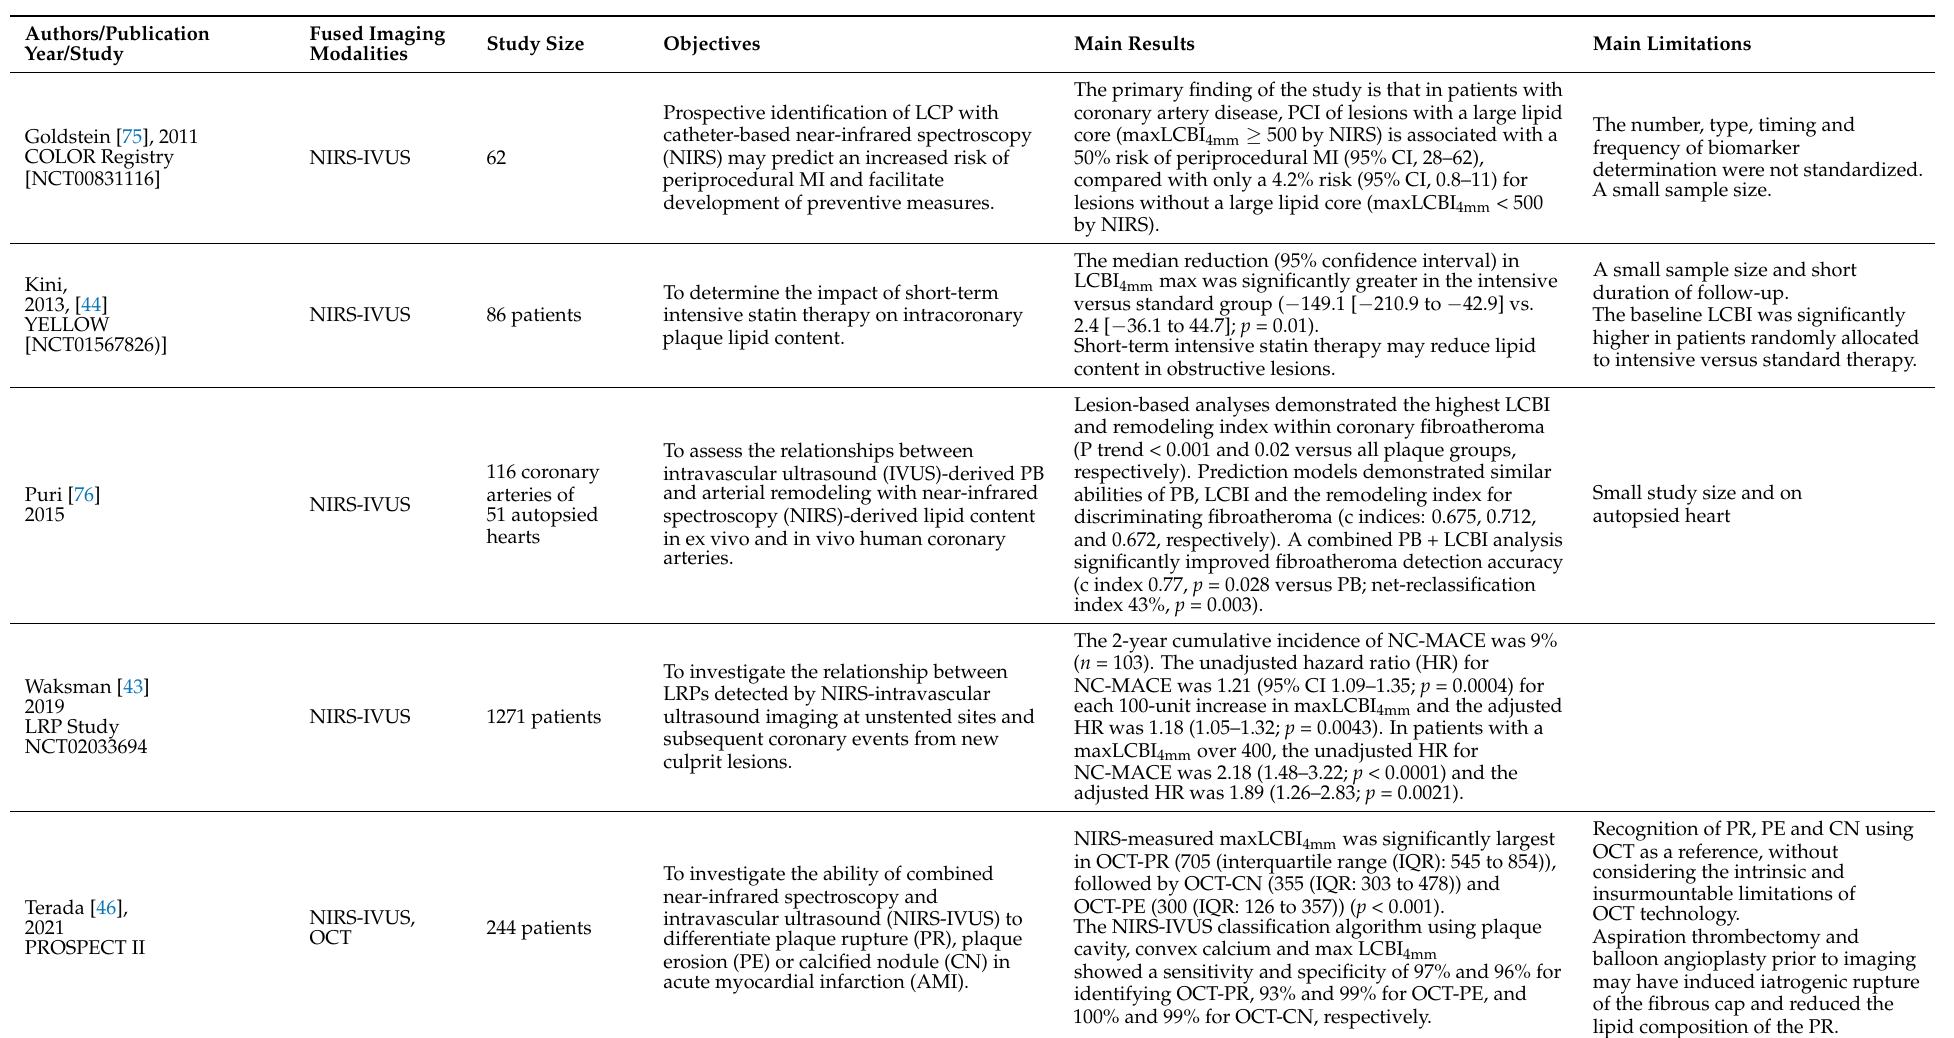
Table 3. Summary of studies with fused intravascular